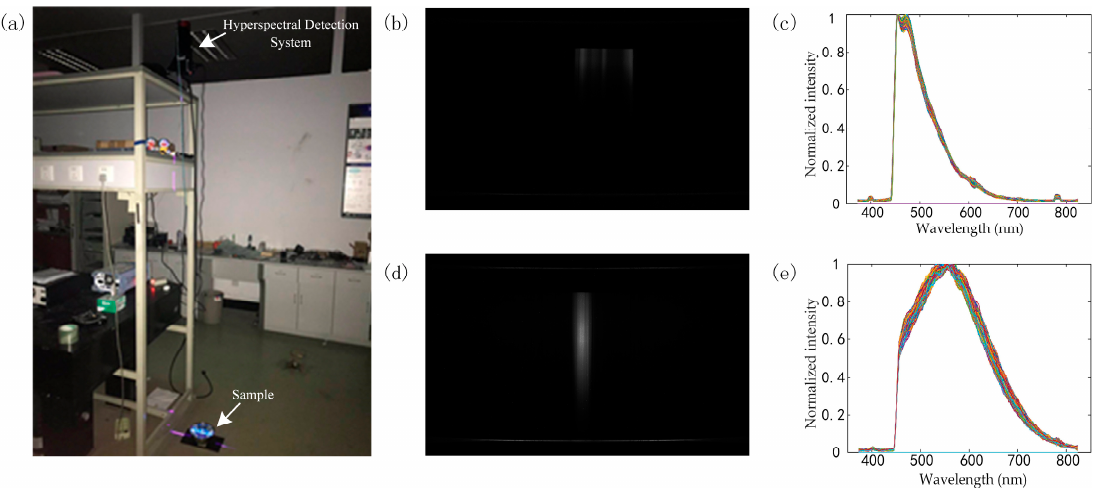
Figure 7. ( a ) The environment of the experiment. ( b ) An image of the fluorescence line of diesel oil, as captured by the camera. ( c ) Normalized spectra of the fluorescence line of diesel oil. ( d ) An image of the fluorescence line of Crude Oil 1, as captured by the camera. ( e ) Normalized spectra of the fluorescence line of Crude Oil 1.